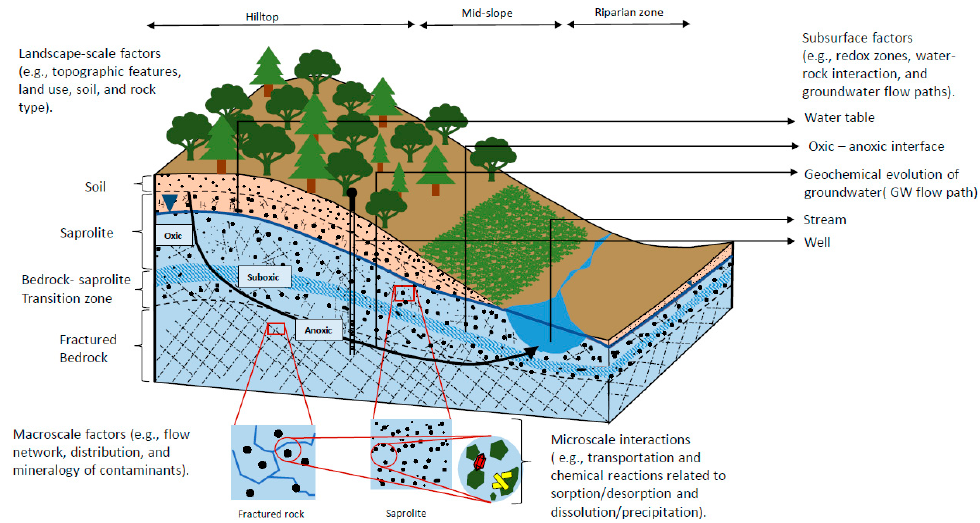
Figure 1. Conceptual model showing geochemical evolution of groundwater in the saturated and unsaturated zones, including the hydrogeochemical factors that influence the contaminant chemistry at multiple scales. Dashed lines indicate lithologic boundaries (modified from [27–29] ).